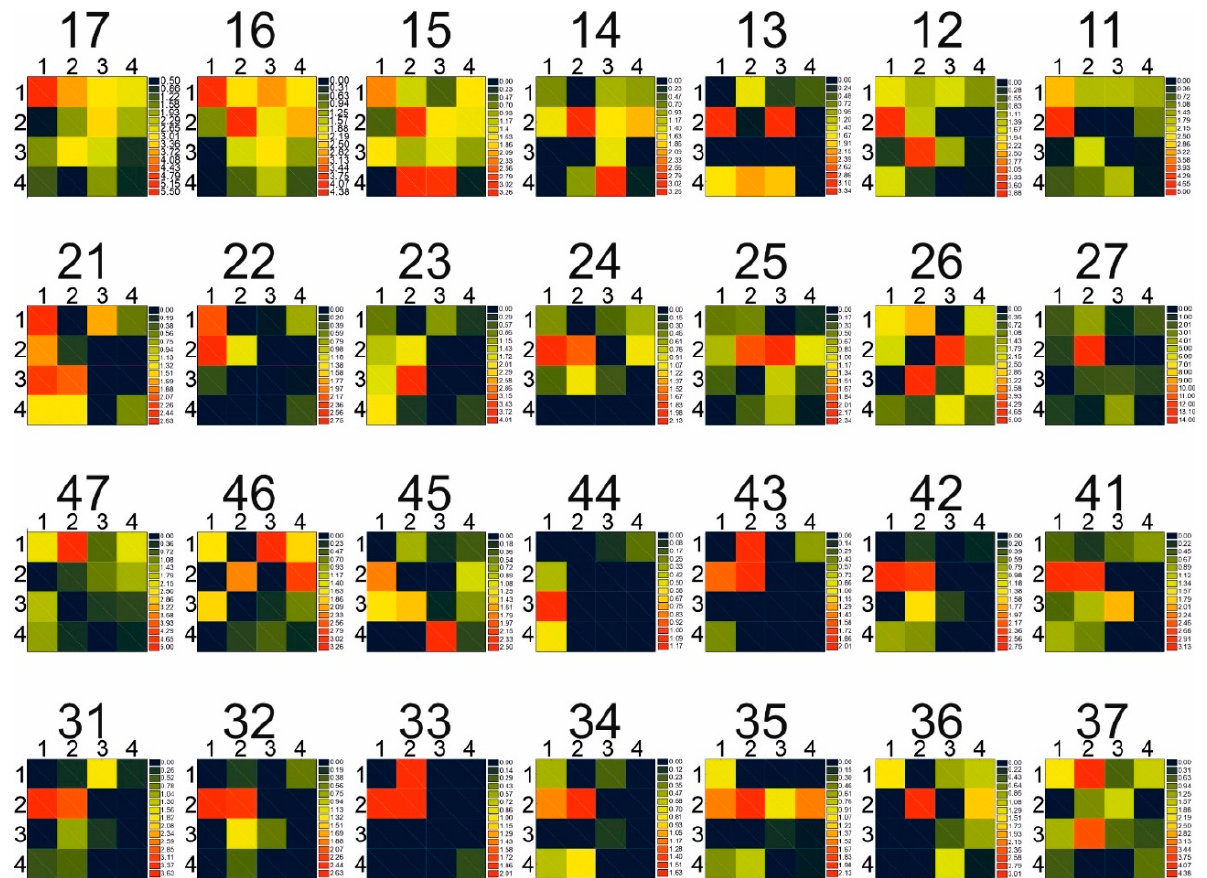
Figure 2. The distribution of study variable values in each neuron that contains a pattern of patients with a comparable minimum distance in accordance with the artificial neural network algorithm for the 28 variables (clinical attachment loss, all tooth) taken into consideration is referred to as the map component for each of the 16 variables. Over each map, the variable under analysis is shown. It is clear that some variables’ values greatly varied between the investigated neurons, whereas their values in other neurons were more or less the same (Table Table 2. Average values of the patient pattern corresponding to each neuron (N) considered.